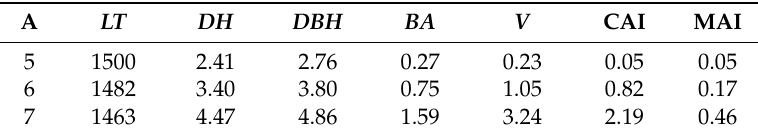
Table 5. Prediction of growth and timber yield for site index ( SI ) of 29 m, considering an initial density of 1500 ha − 1 trees at 5